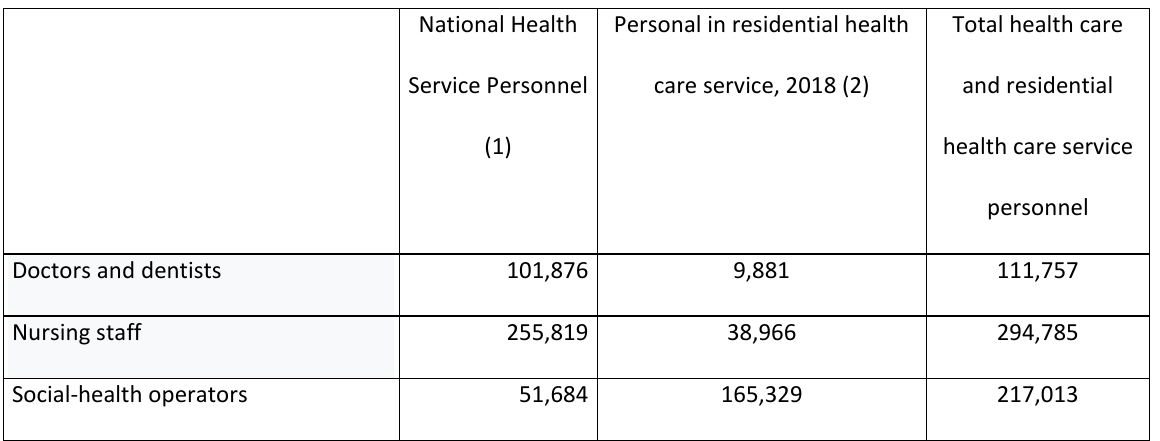
Table 1 . Health care professional in Italy (last available